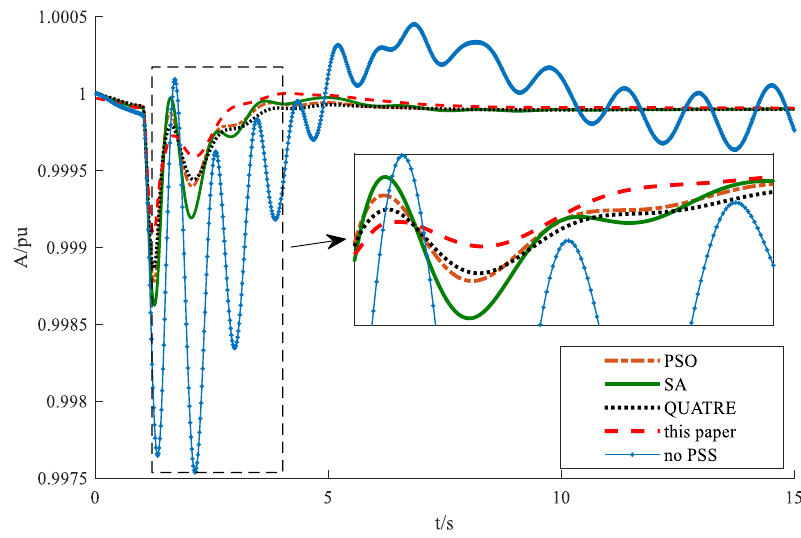
Figure 9. IEEE 4-machine 2-area system. Table 5. Characteristic root and damping ratio of the system after designing PSS by different meth- ods.